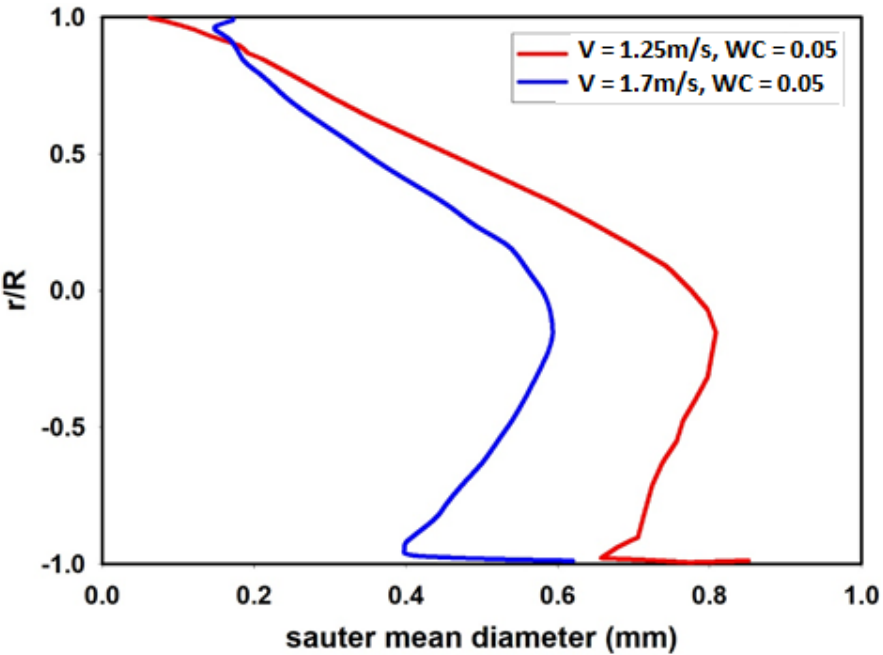
Figure 2. Vertical distribution of Sauter mean diameter across pipe section as obtained by the CFD model for test 1 (V = 1.25 m/s, water cut = 0.05) and test 2 (V = 1.7 m/s, water cut = 0.05).